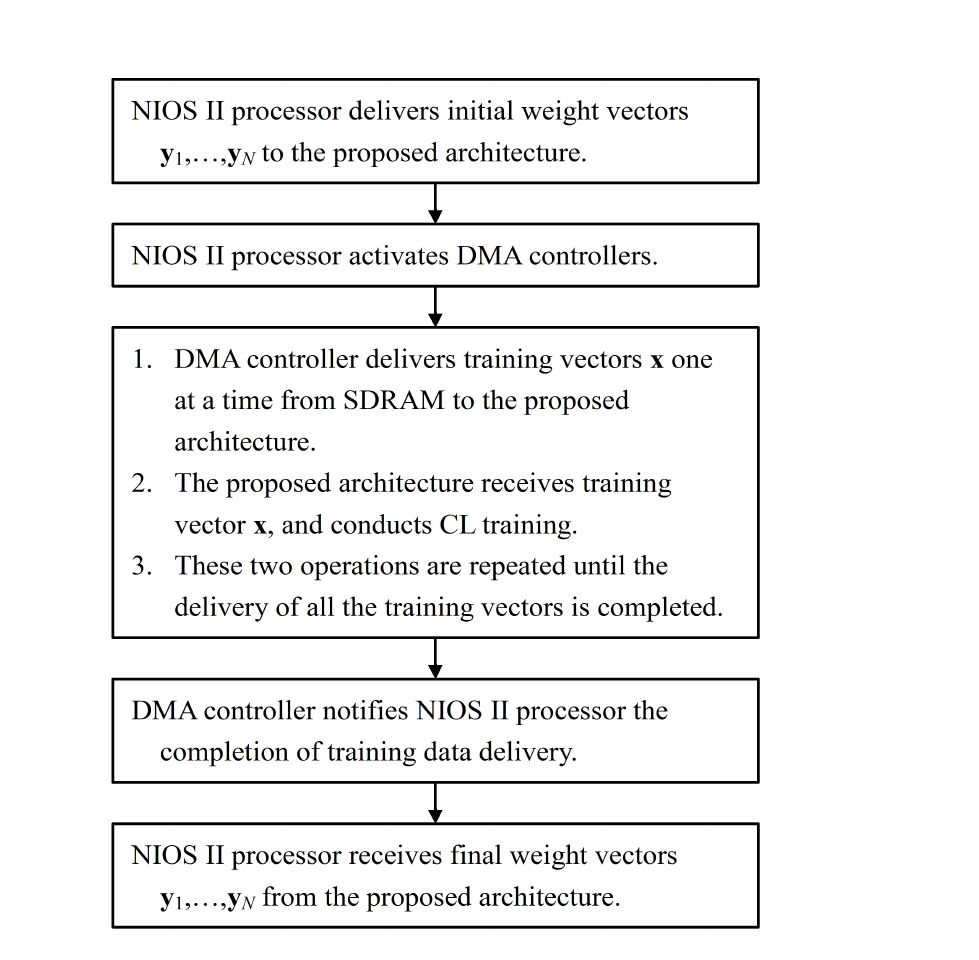
Figure 16. The flowchart of operations in the